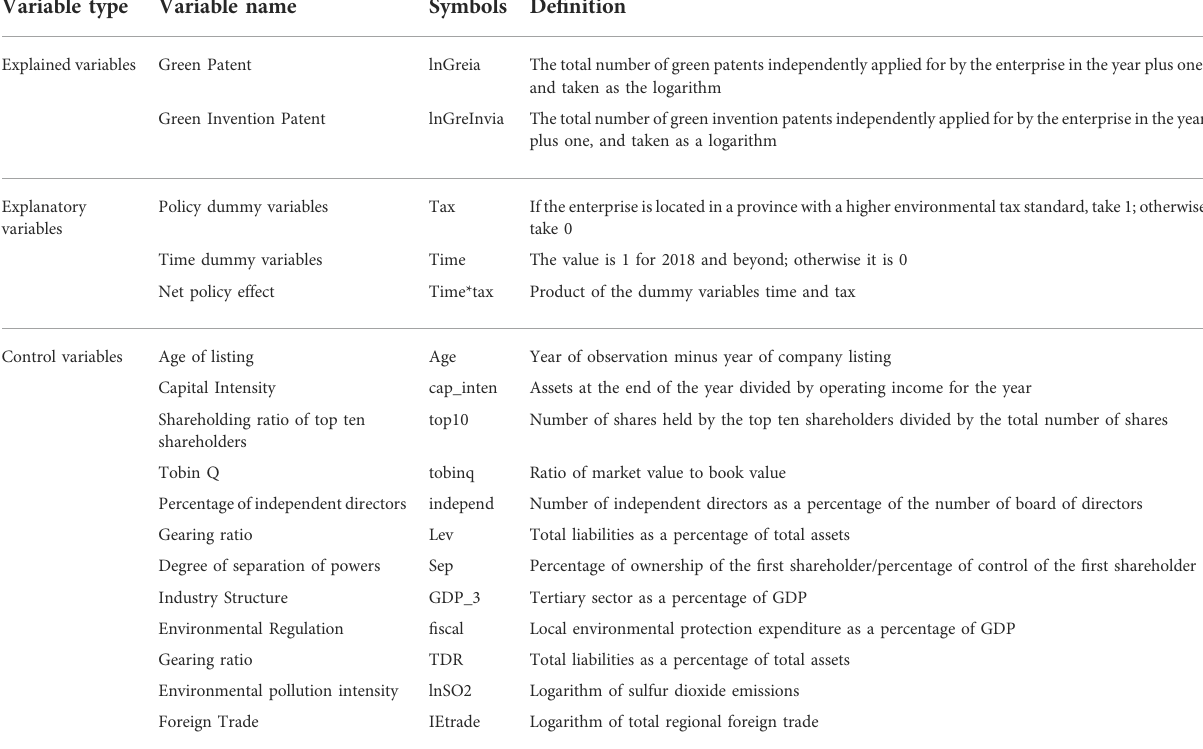
TABLE 2 De fi nition of main variables.